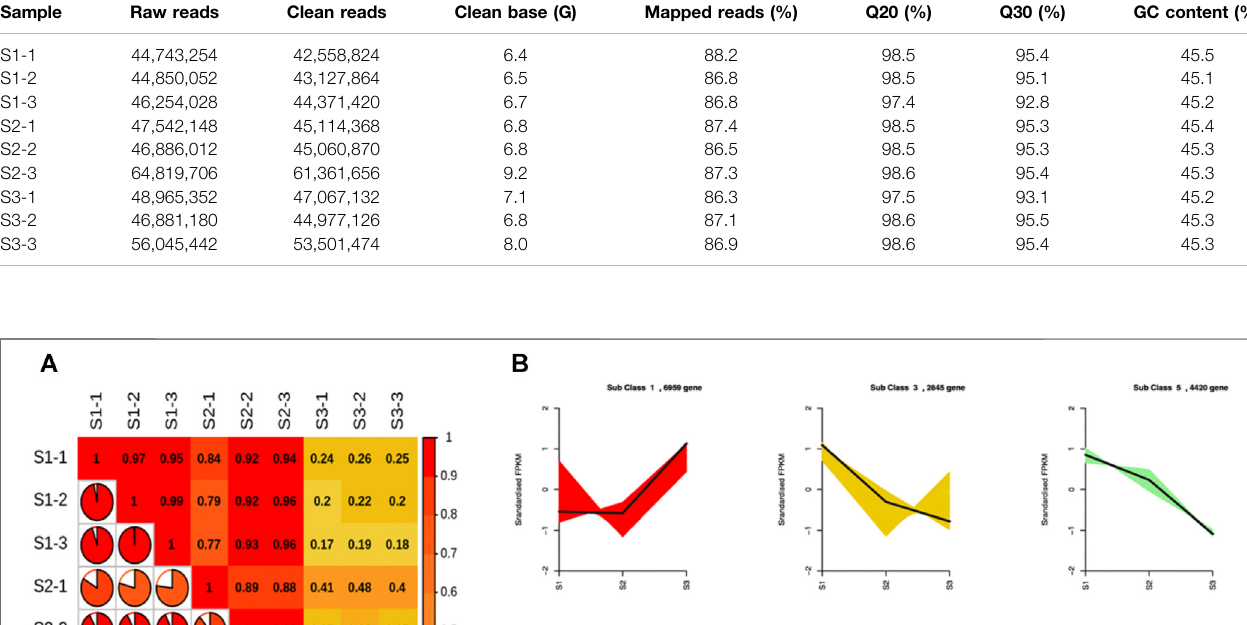
TABLE 1 | Summary of transcriptome analysis for three developmental stages of M. ternifolia nutshell. Sample